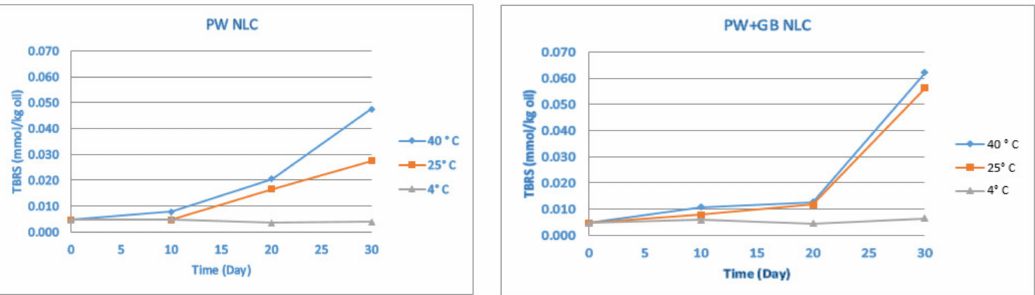
Figure 4. Oxidative stability of β -sitosterol NLC dispersions by thiobarbituric acid reactive substance (TBARS) (mmol / kg oil) during storage at di ff erent temperatures (4, 25 and 40 ◦ C). PW and PW + GB represent the NLCs formulated with propolis wax alone or its binary mixture with glyceryl behenate (1:1),